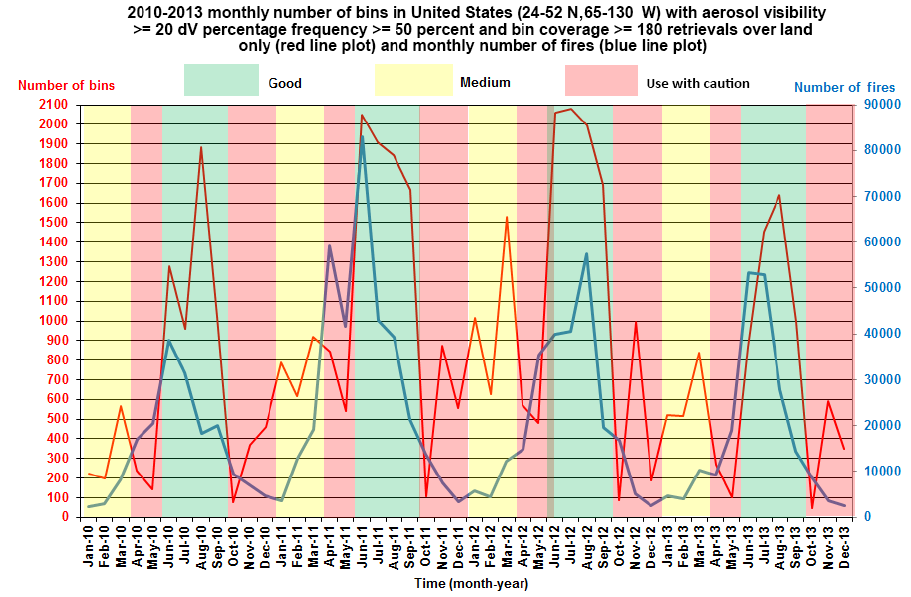
Figure 3. Monthly frequency of land-only bins that had a percentage frequency of at least 50% of aerosol visibility values ≥ 20d V and of at least 180 retrieval counts (red line plot) and monthly frequency of WF-ABBA detected fires (blue line plot) by month in the United States (24–52 ◦ N latitude and 65–130 ◦ W longitude) for January 2010 through December